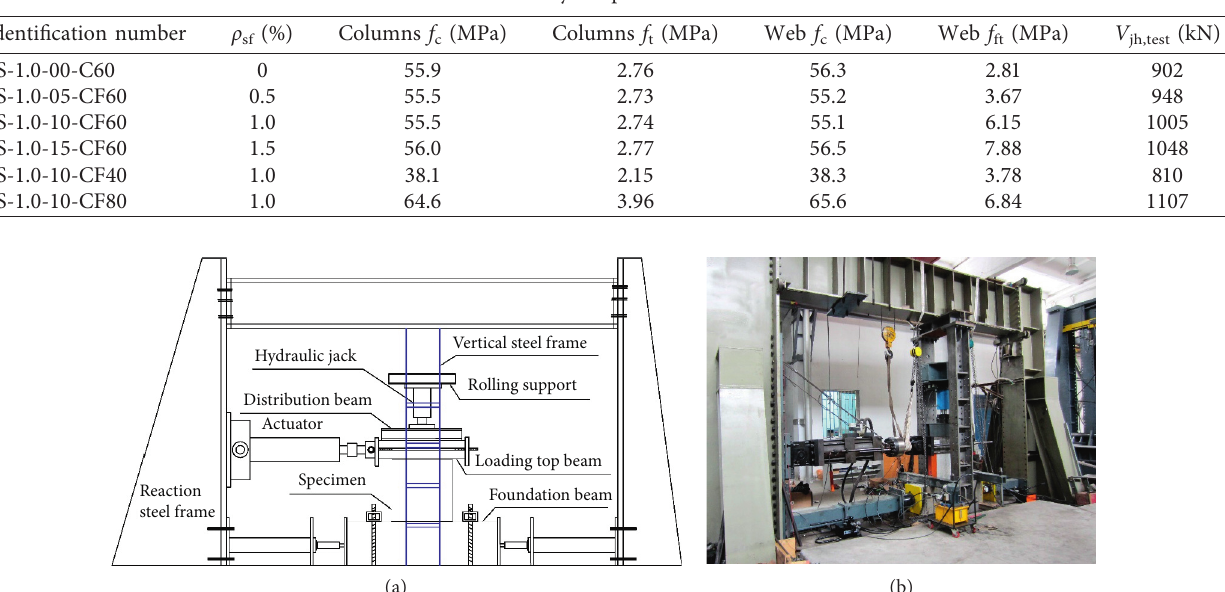
Table 2: Summary of specimen information.